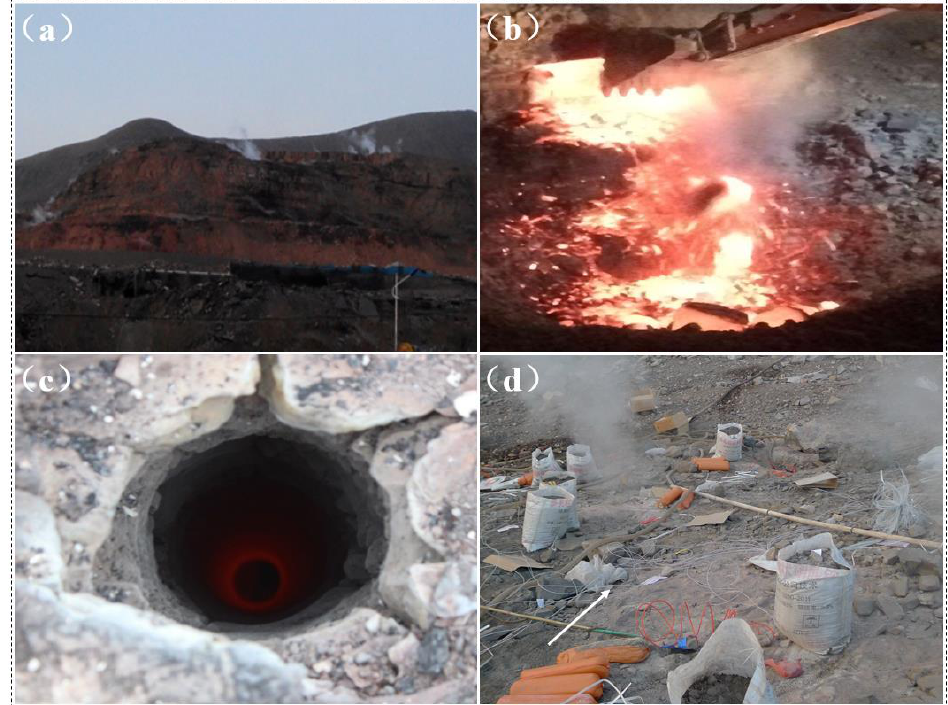
Figure 1. Blasting mining site, field photograph, December 2021, in Dashitou coalfield fires approximately 10 km northwest of Ruqigou in Ningxia province. ( a ) A long-time heated open pit coal mine (the color of the mountain is dark red), ( b ) spontaneous combustion coal seam, ( c ) high-temperature blast hole (the temperature can reach 400 °C) and ( d ) high-temperature blasting site.